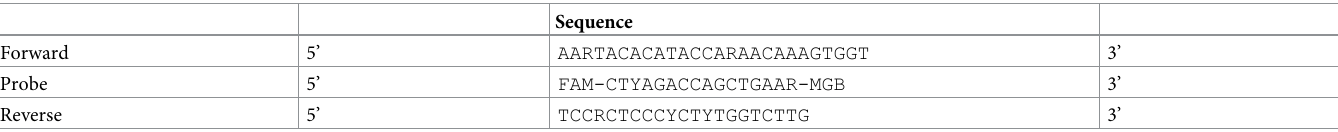
Table 1. Sequence of primers and